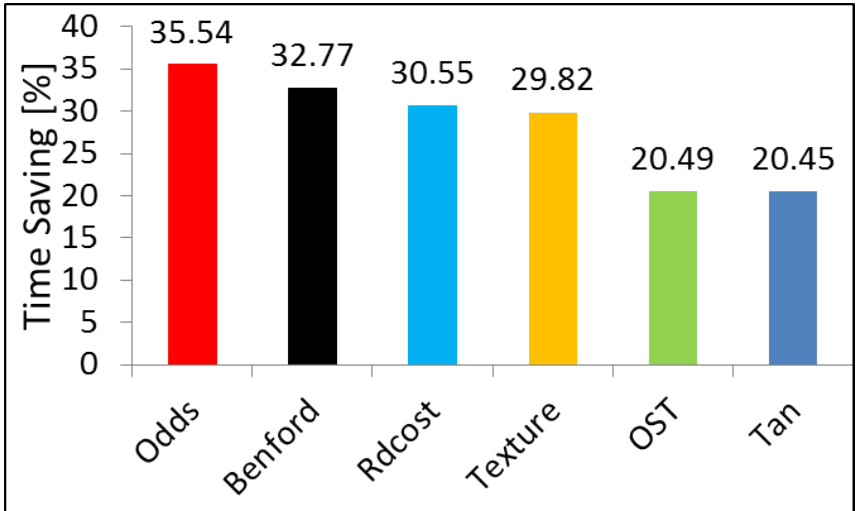
Figure 9. Time saving achieved by various